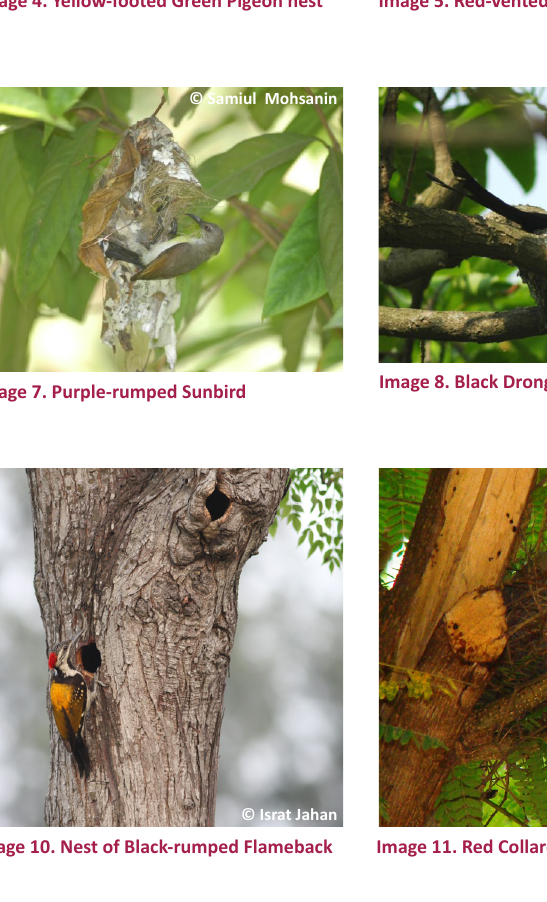
Image 4. Yellow-footed Green Pigeon nest